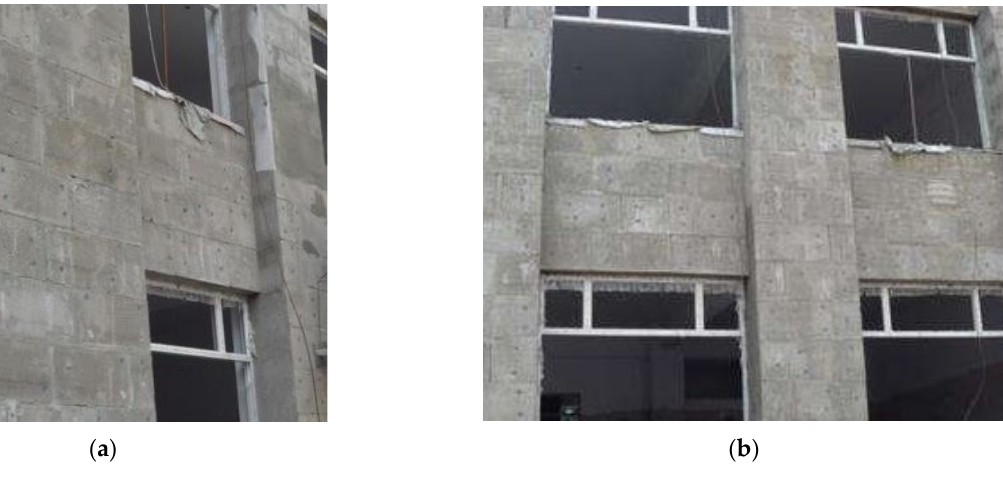
Figure 15. Building #1 exterior insulated wall panel: ( a ) Side view; ( b ) Front view.